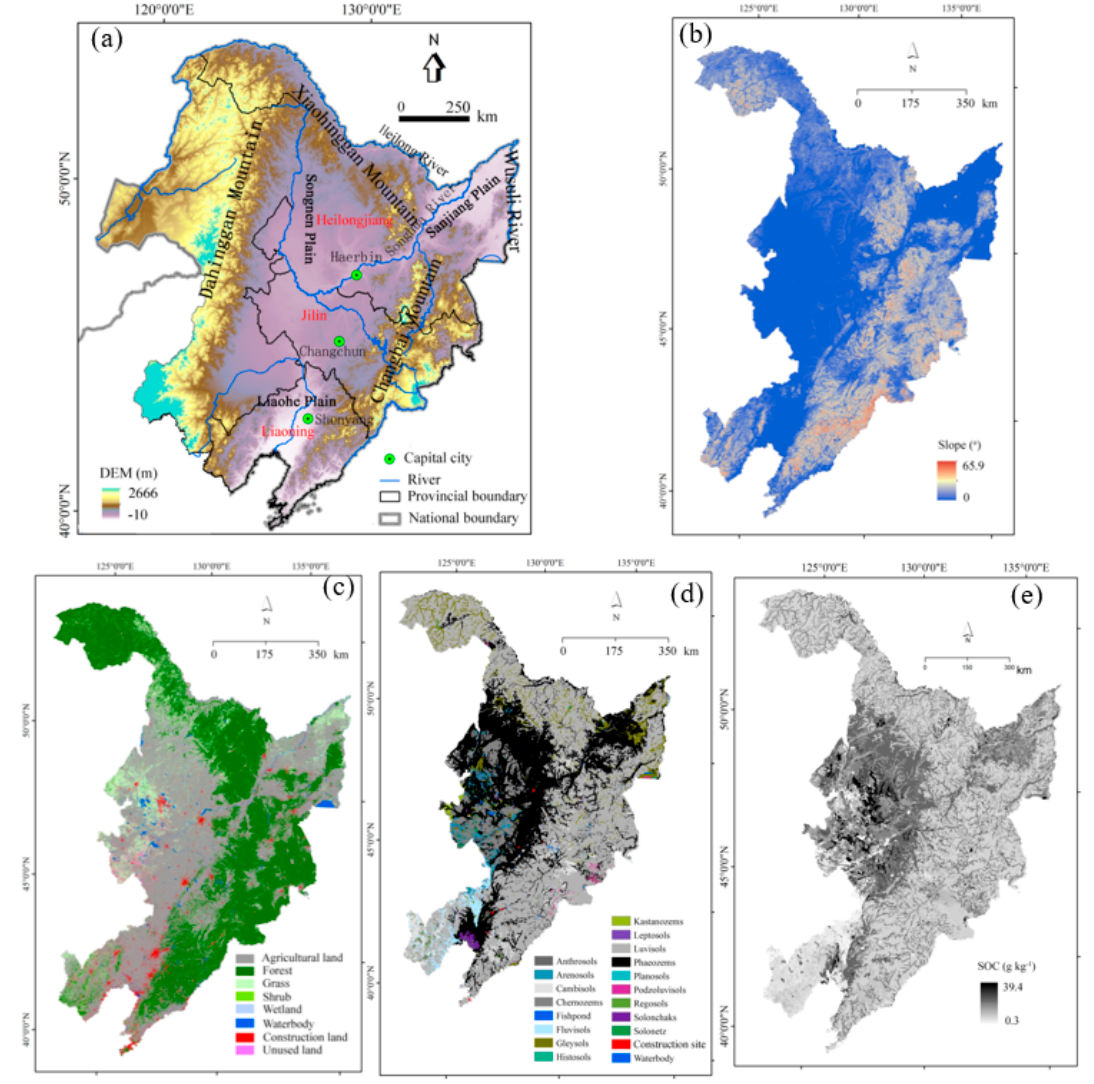
Figure 1. ( a ) Location of the study area, ( b ) slope, ( c ) land use, ( d ) soil distribution, ( e ) soil organic carbon (SOC) content in the top 30 cm soil layer.